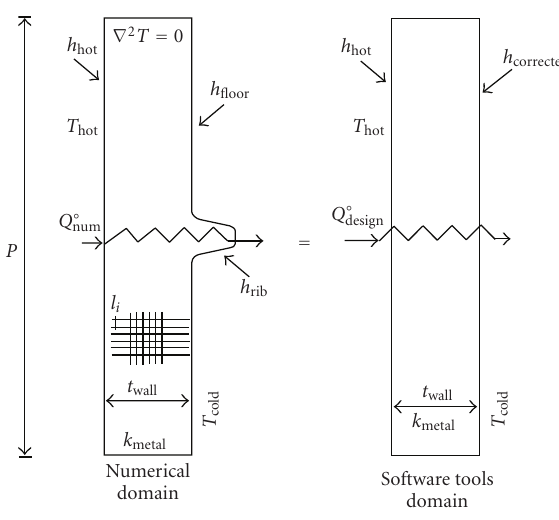
Figure 2: Equivalent thermal